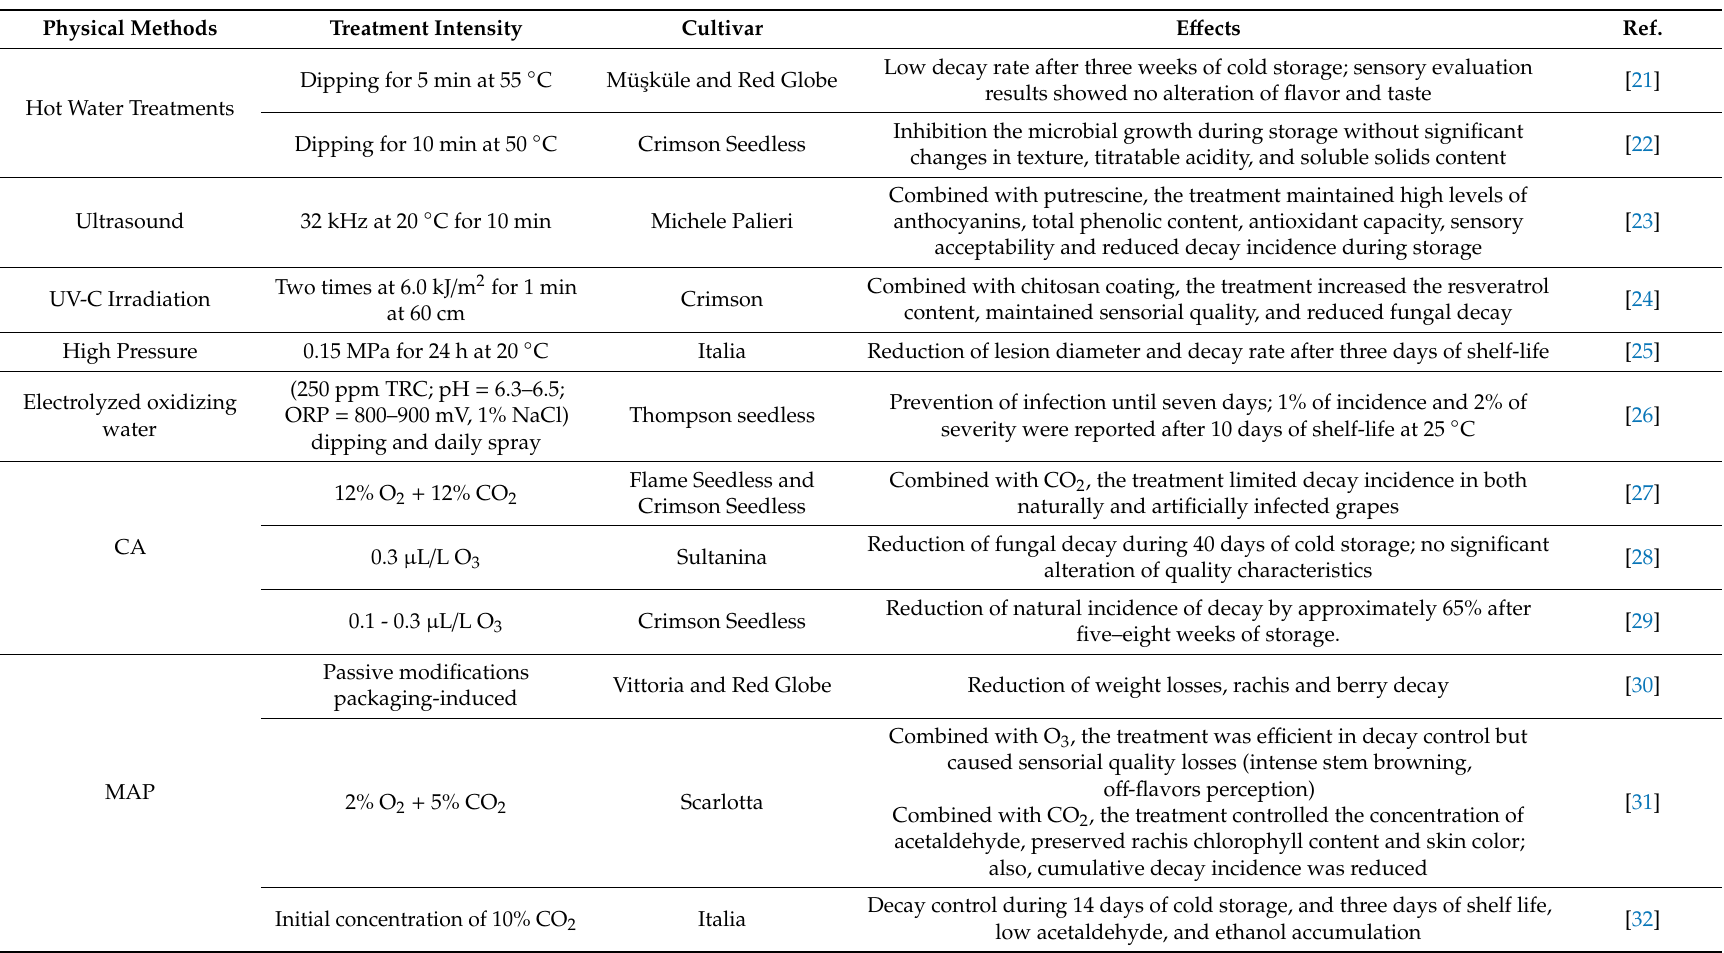
Table 1. Main physical methods investigated in the last ten years against grey mould decay in table